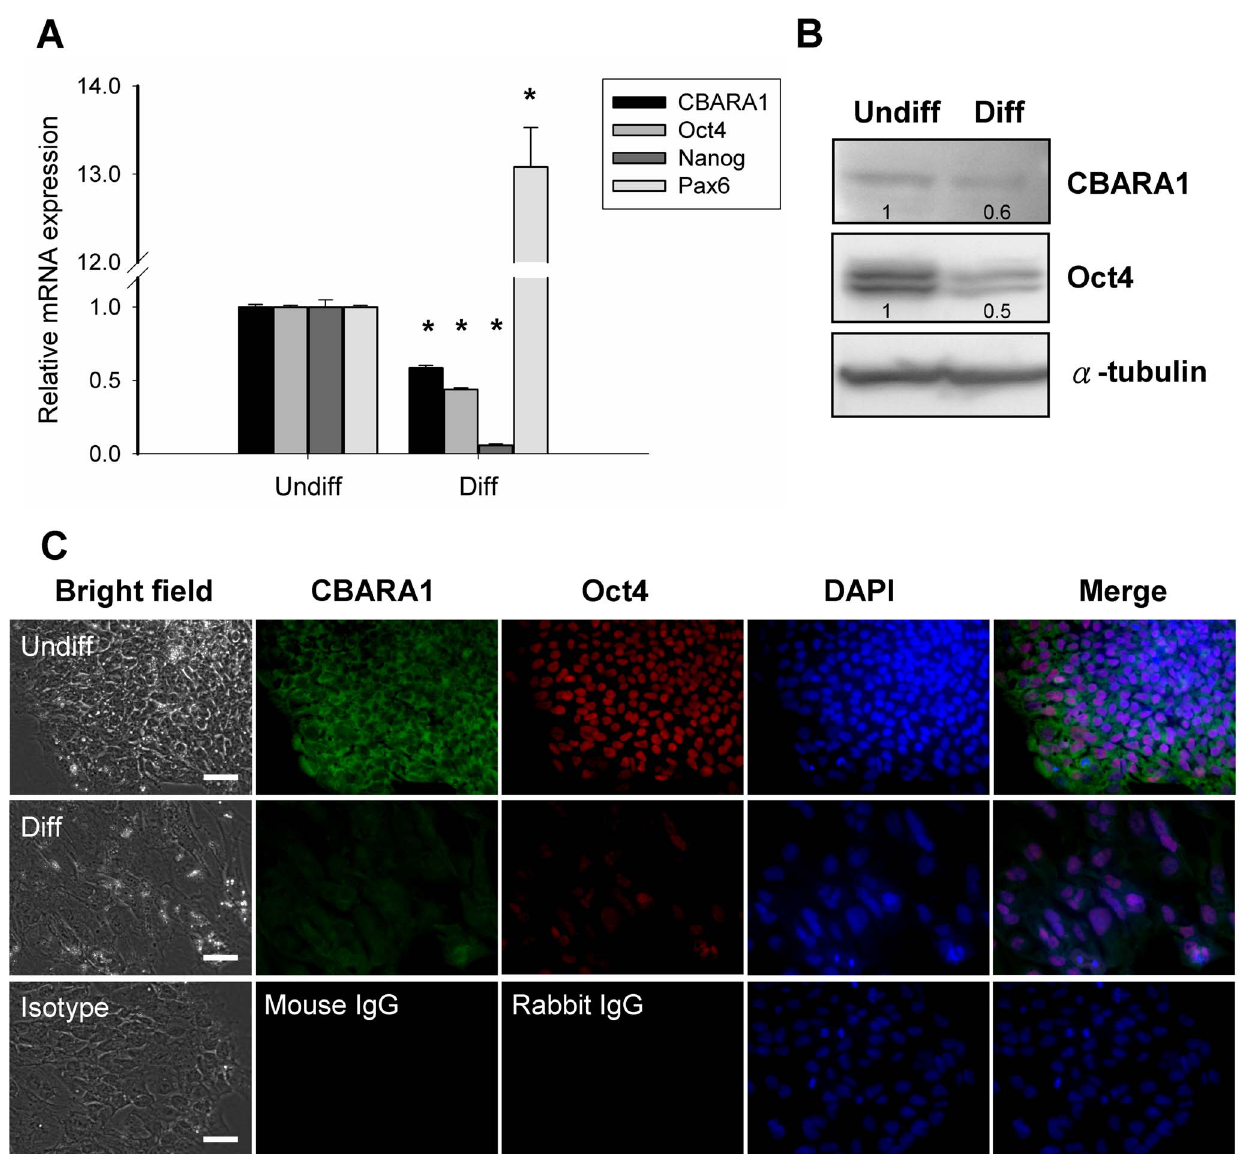
Figure 1. CBARA1 is a marker for undifferentiated hESCs. (A) Quantitative PCR was used to determine CBARA1 and Oct4 mRNA levels in undifferentiated TW1 hESCs and noggin-induced differentiated cells. Gene expression was normalized to GAPDH expression and is presented as the fold-change compared to expression in undifferentiated hESCs. The bars show the means 6 standard deviations of three independent experiments. *Significant difference compared to undifferentiated hESCs ( P , 0.01). (B) Western blot showing CBARA1 protein levels in undifferentiated and 7-day differentiated hESCs. a -tubulin was used as a loading control. The relative reduction of CBARA1 in 7-day differentiated cells was quantified by densitometry as shown under the blots. (C) Representative images show CBARA1 and Oct4 immunostaining in undifferentiated or 7-day differentiated hESCs. Abbreviations: Undiff, undifferentiated hESC; Diff, differentiated hESC. Scale bar=50 m m.